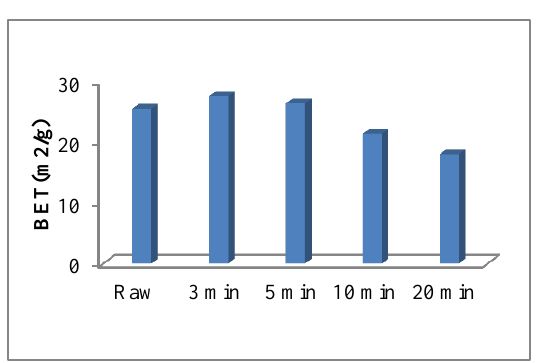
Fig.3. Change of the specific surface area of zeolite samples with milling